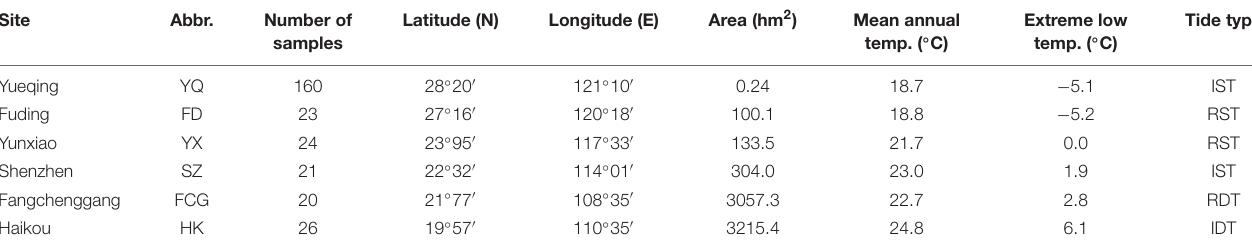
FIGURE 1 | (A) Map of the study areas in China with details of the localities of six K. obovata populations and their average temperatures in January (from China Meteorological Data Sharing Service System). (B) K. obovata grown in YQ, from top to bottom, before the chilling event, 5 months after the chilling event, and 10 months after the event, respectively. The red boxes in the pictures indicate the same individual. TABLE 1 | Geographic information and meteorological characteristics of the areas where the studied populations are